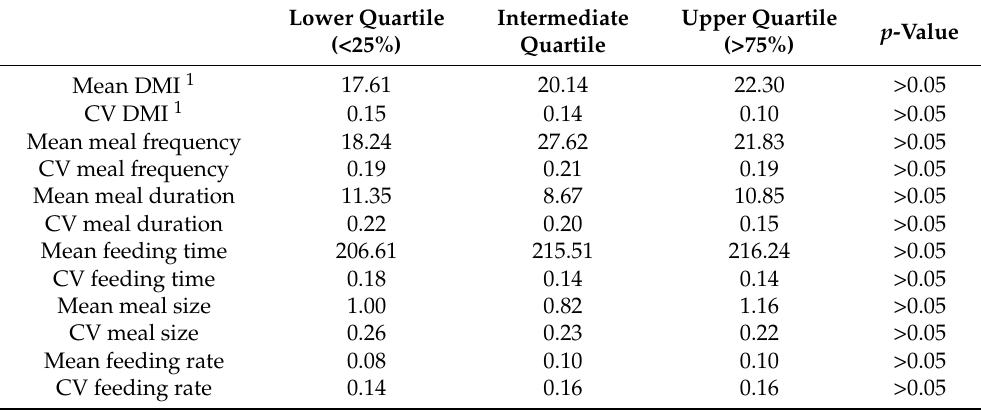
Table 5. Mean and CV values of DMI and intake behavior of early lactating dairy cows grouped in quartiles according to mean DMI observed between week 2 and 15 of